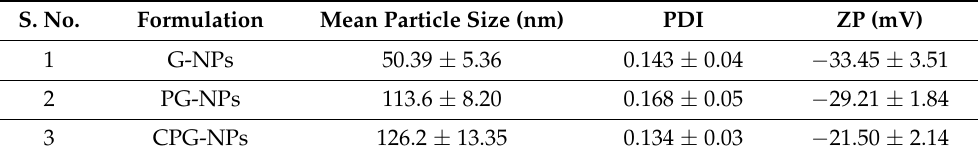
Table 1. Particle size, PDI, and ZP of the given formulations ( n = 3). S.